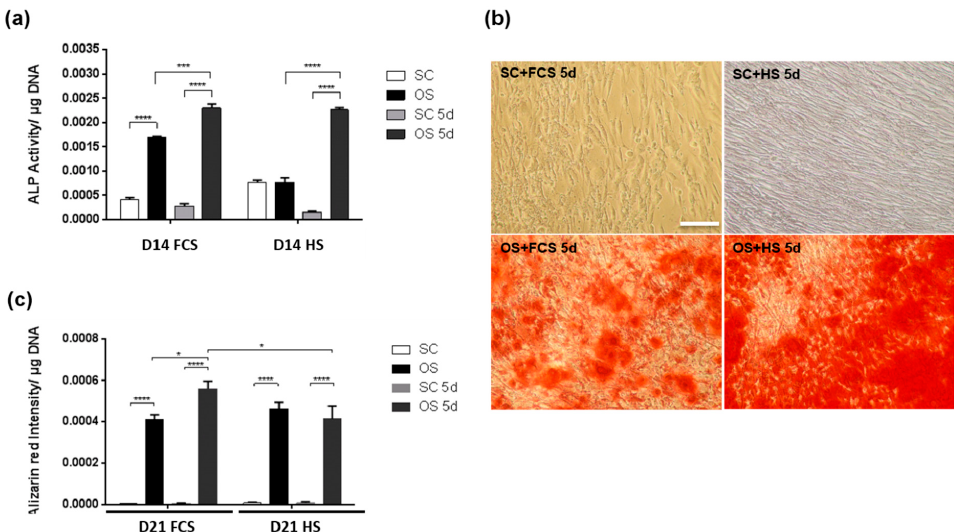
Figure 6. Osteogenic response of primary MSCs in the presence of FCS or HS. ( a ) Alkaline phosphatase activity in MSCs cultured for 21 days in SC, OS, SC 5-Day serum and OS 5-Day serum culture media with FCS or HS. ( b ) Alizarin red staining of MSC cultures after 21 days in SC or OS medium with transient serum exposure using FCS or HS. Scale bar = 200 µm. ( c ) Alizarin red quantification for MSCs cultured for 21 days. * p < 0.05, **** p < 0.00005 ( n = 6).